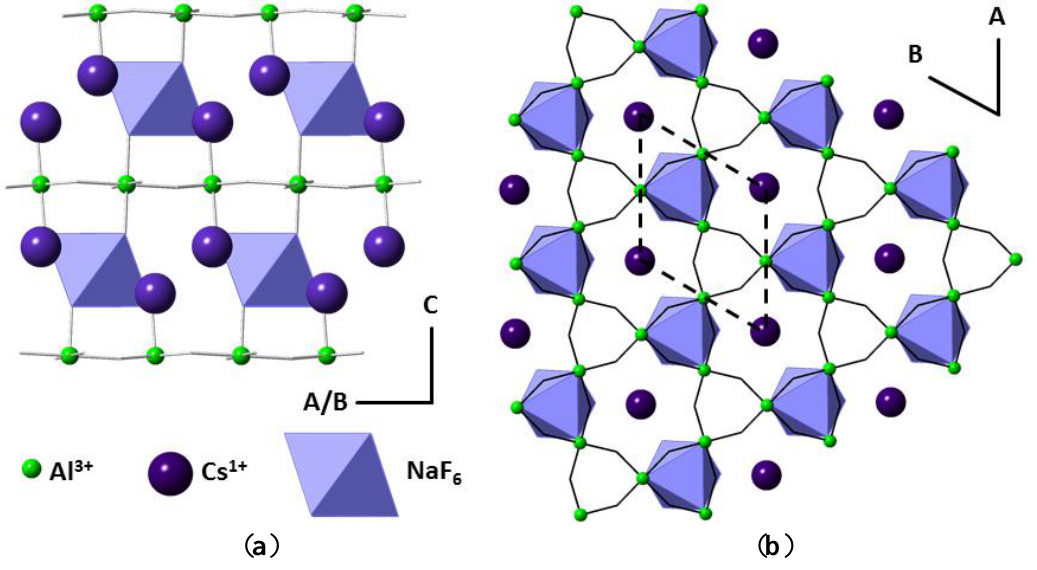
Figure 1. View along the ab -plane ( a ) and down the c -axis ( b ) of the aristotype structure of Cs 2 NaAl 3 F 12